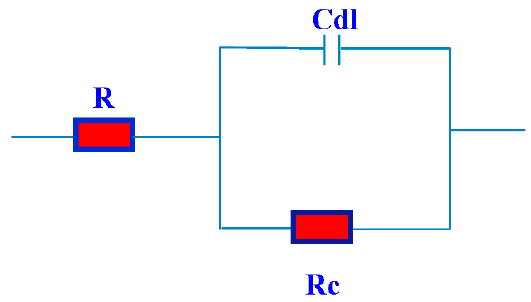
Figure 7. The influence of T3EA concentrations on the the Nyquist plots of steel in acidic chloride solution.